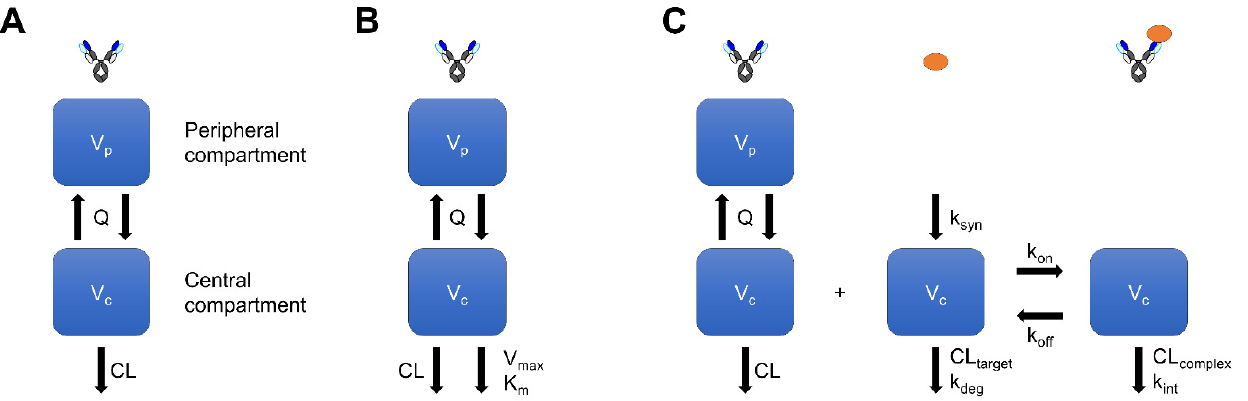
Figure 1. Basic model structure of ( A ). two-compartment model, ( B ). Michaelis–Menten model, ( C ). target-mediated drug disposition model. CL; clearance, Q; inter-compartmental CL, V c ; volume of distribution in the central compartment, V p ; volume of distribution in the peripheral compartment, K m ; Michaelis constant, V max ; maximum rate of nonlinear elimination, k syn ; synthesis rate of target antigen, CL target /k deg ; elimination clearance/rate constant of target antigen, CL complex /k int ; elimination clearance/internalization rate constant of complex, k on ; association rate constant, k off ; dissociation rate constant.